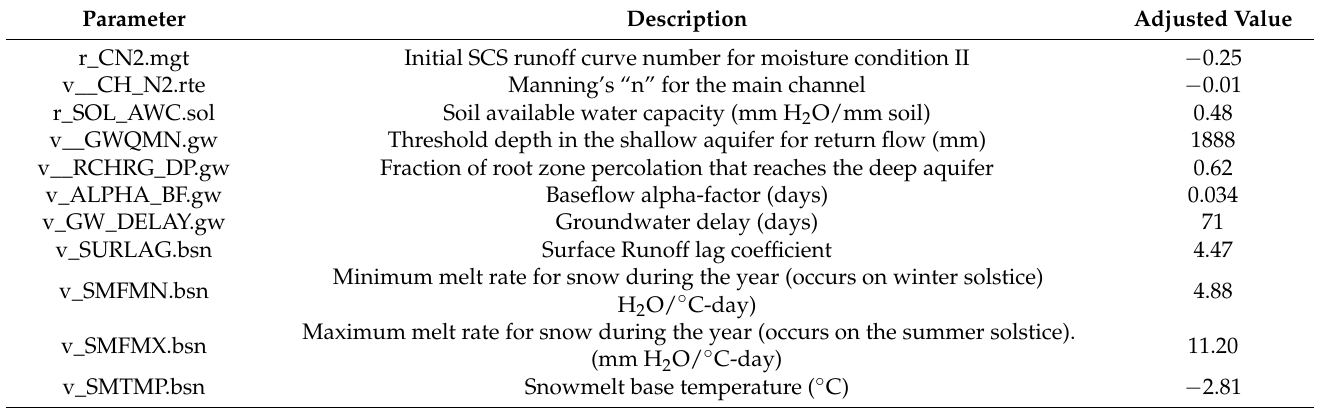
Figure 6. Flowsheet diagram of the SWAT model. Table 3. List of parameters used for calibrating of the SWAT